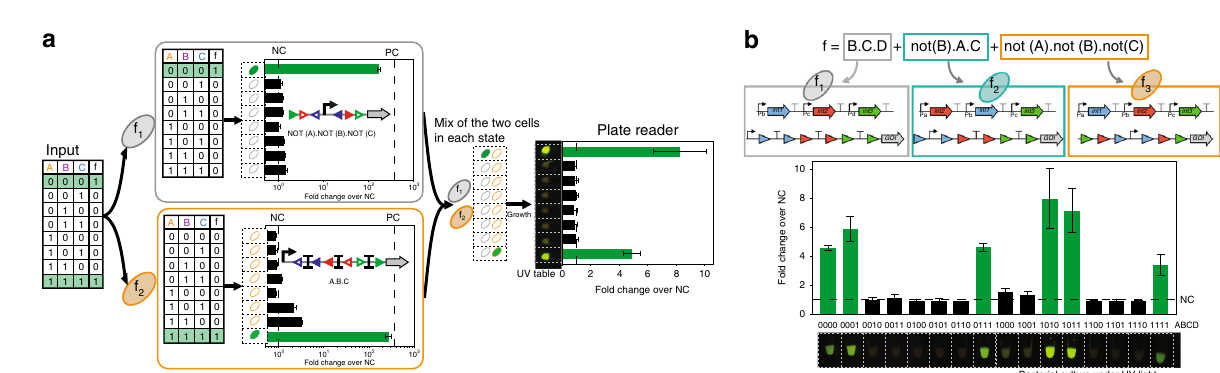
Fig. 5 Prototyping multicellular recombinase logic. a Work fl ow for multicellular logic system prototyping. The consensus 3-input function is decomposed in two sub-functions implemented using two logic devices. To prototype this logic system for each input state, we mixed the two strains containing the recombinase logic device and different constitutive integrase cassettes corresponding to the different input states. After overnight growth, we measured the bulk fl uorescence intensity of the whole-population using a plate reader. Bar graphs corresponds to the fold change in GFP median fl uorescence intensity over the negative control. NC Negative Control (no promoter), PC positive control (promoter-RBS-GFP). Data are from two experiments performed in different days with three replicates per experiment. Error bars: ±s.d. The photograph correspond to three co-culture replicates for each state centrifuged together, resuspended in 20 µ L and observed under a UV light. b Prototyping a 4-input, 3-strain multicellular logic system. The bar graphs and pictures were obtained as in ( b ). Source data are provided as a Source Data fi le NATURE COMMUNICATIONS| (2019) 10:456